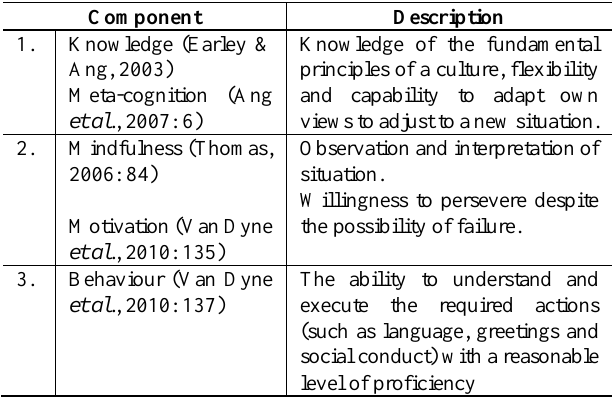
Table 1: Summary of the components of cultural